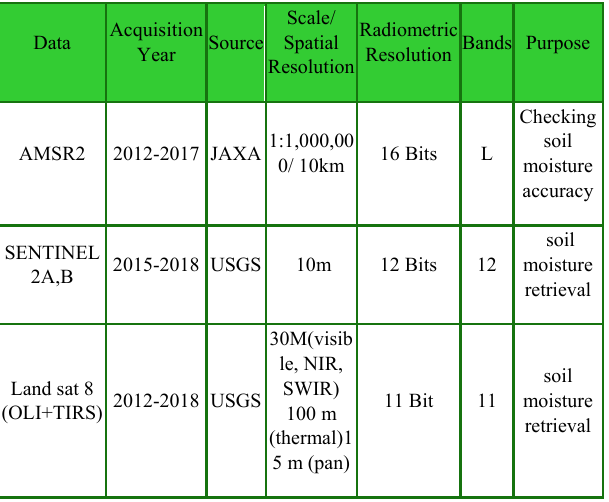
Table 1: Description of datasets used